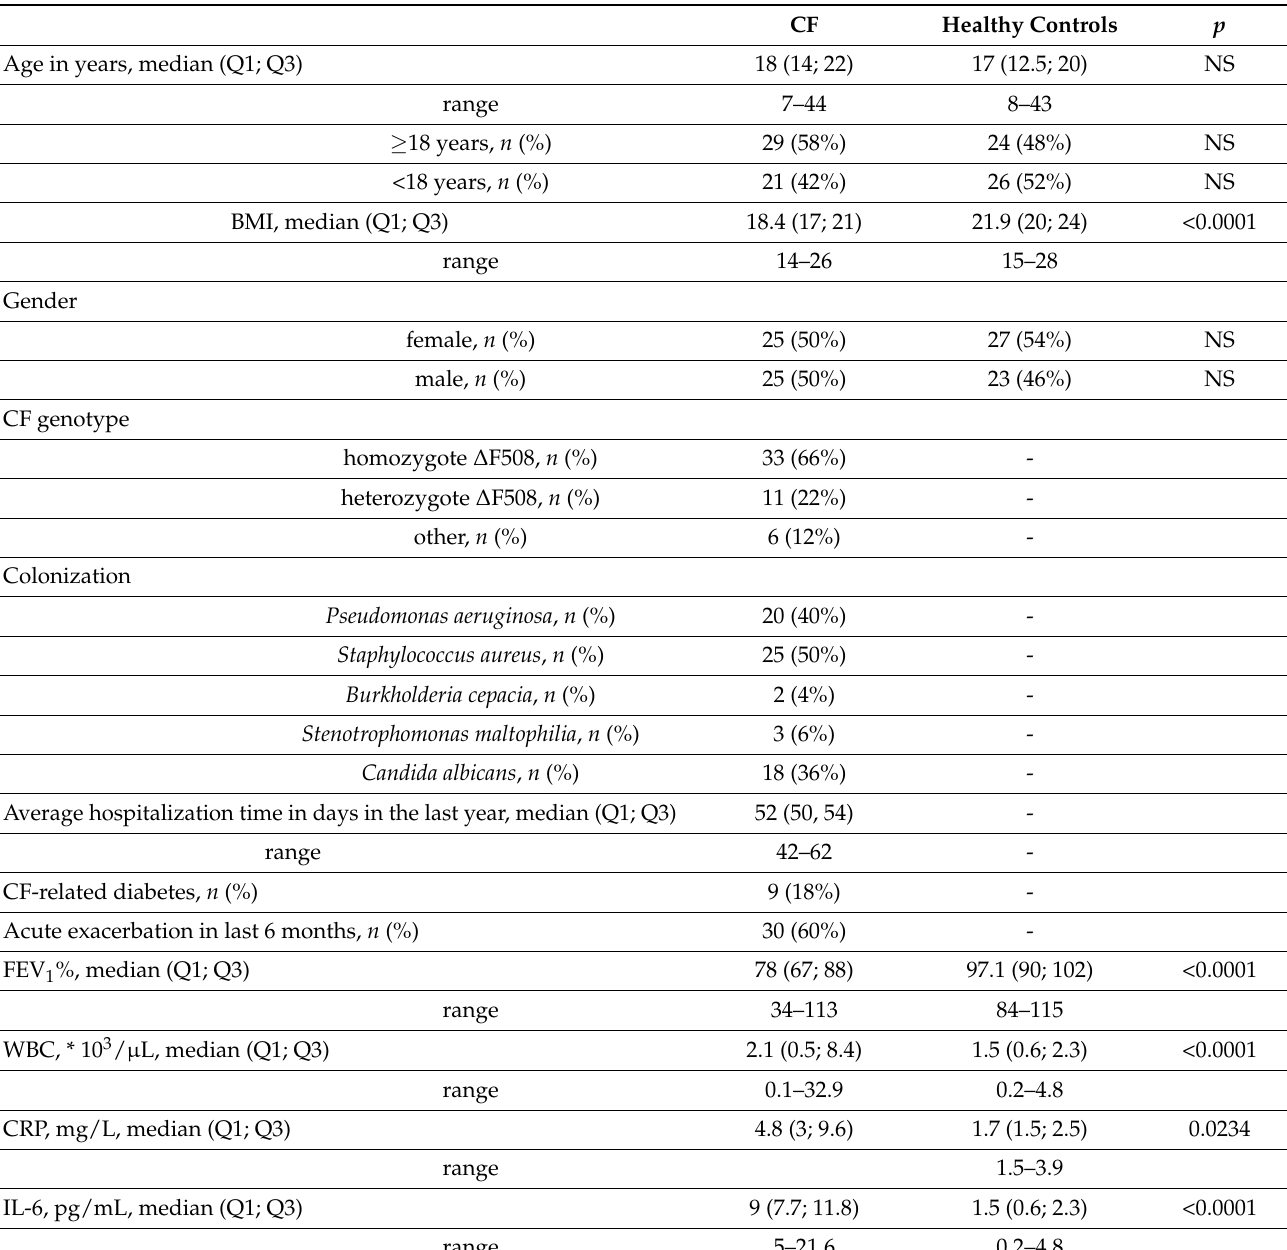
Table 1. Demographic and clinical characteristics of the studied groups